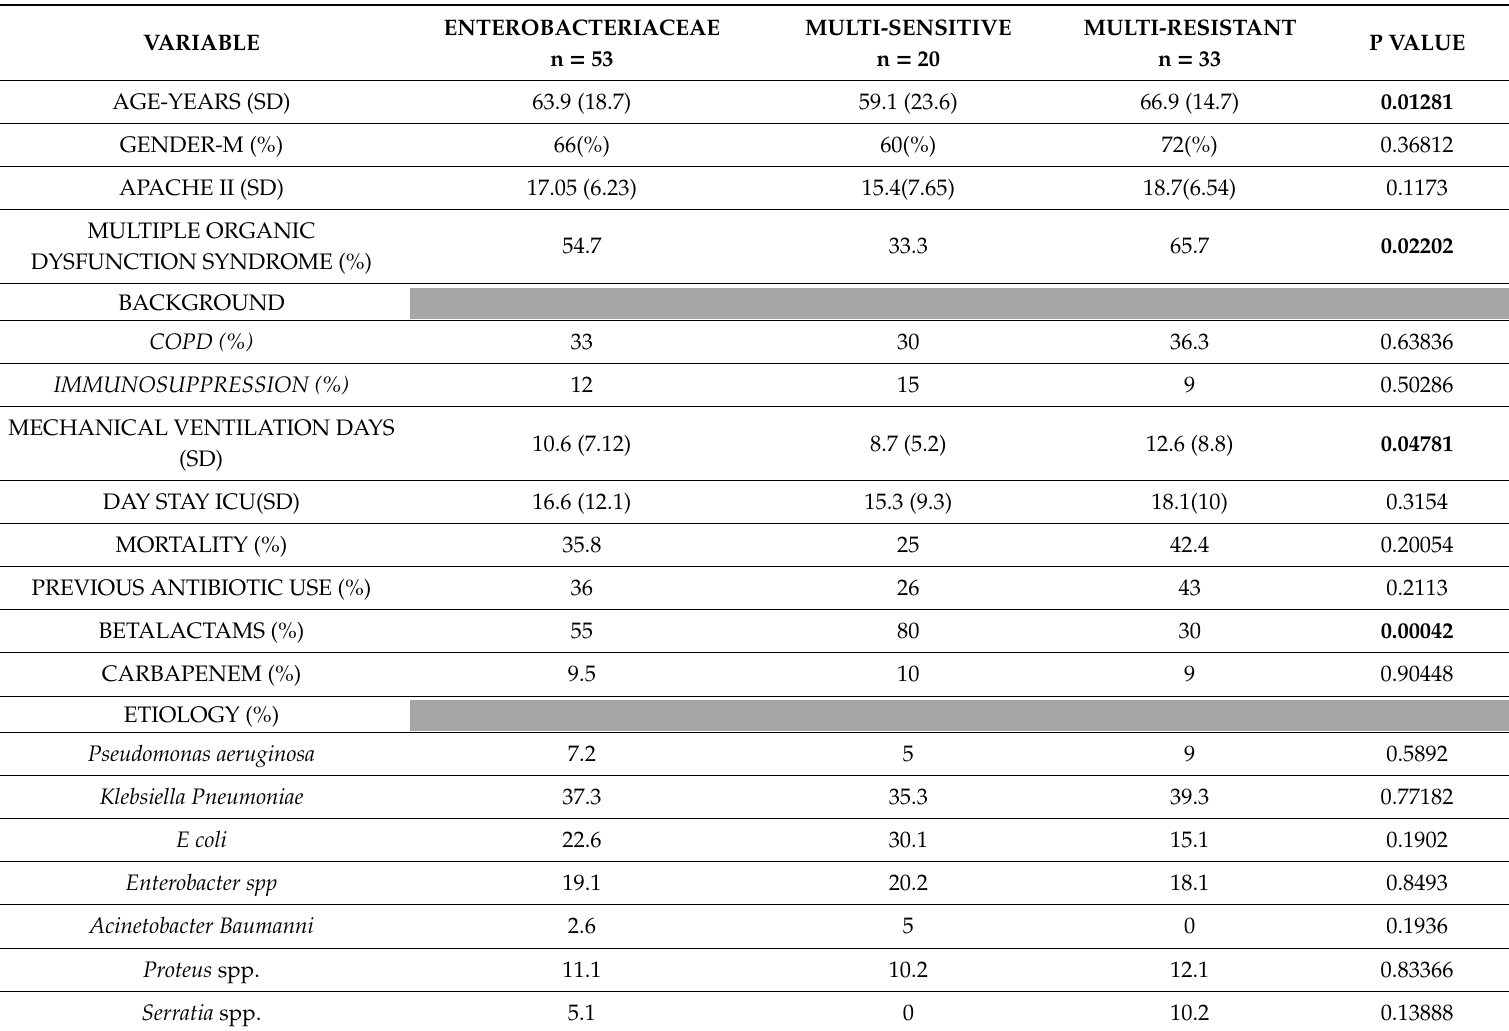
Table 1. Demographics and characteristics of pneumonia severe for